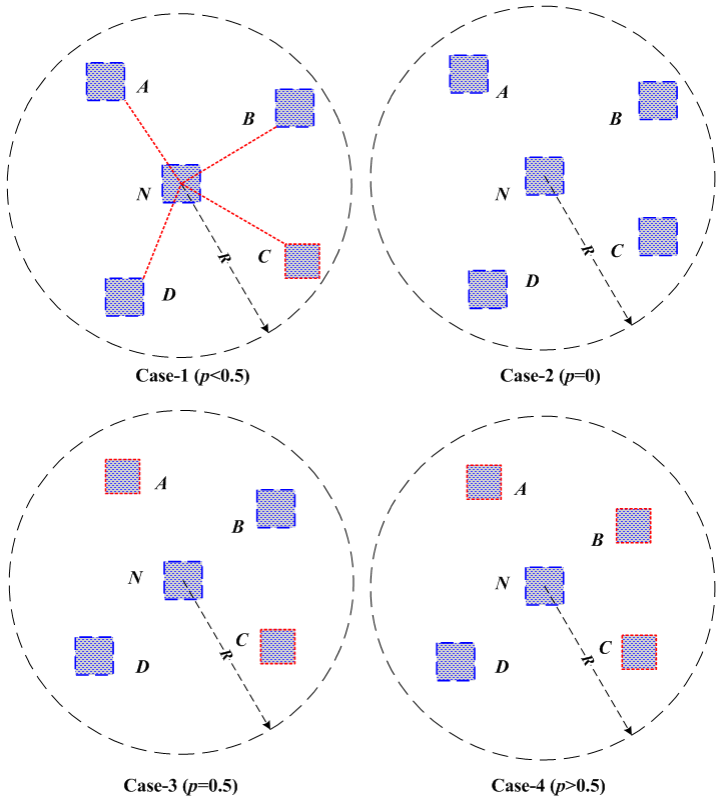
Figure 5. Four cases of different malicious anchor